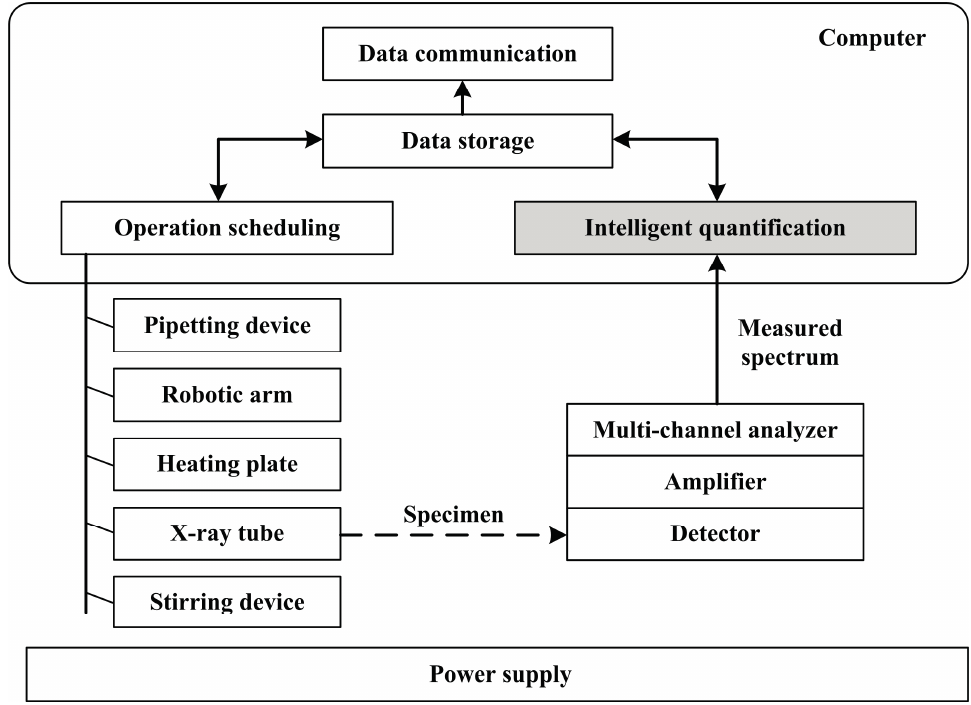
Figure 2. Structure of the online TXRF analysis